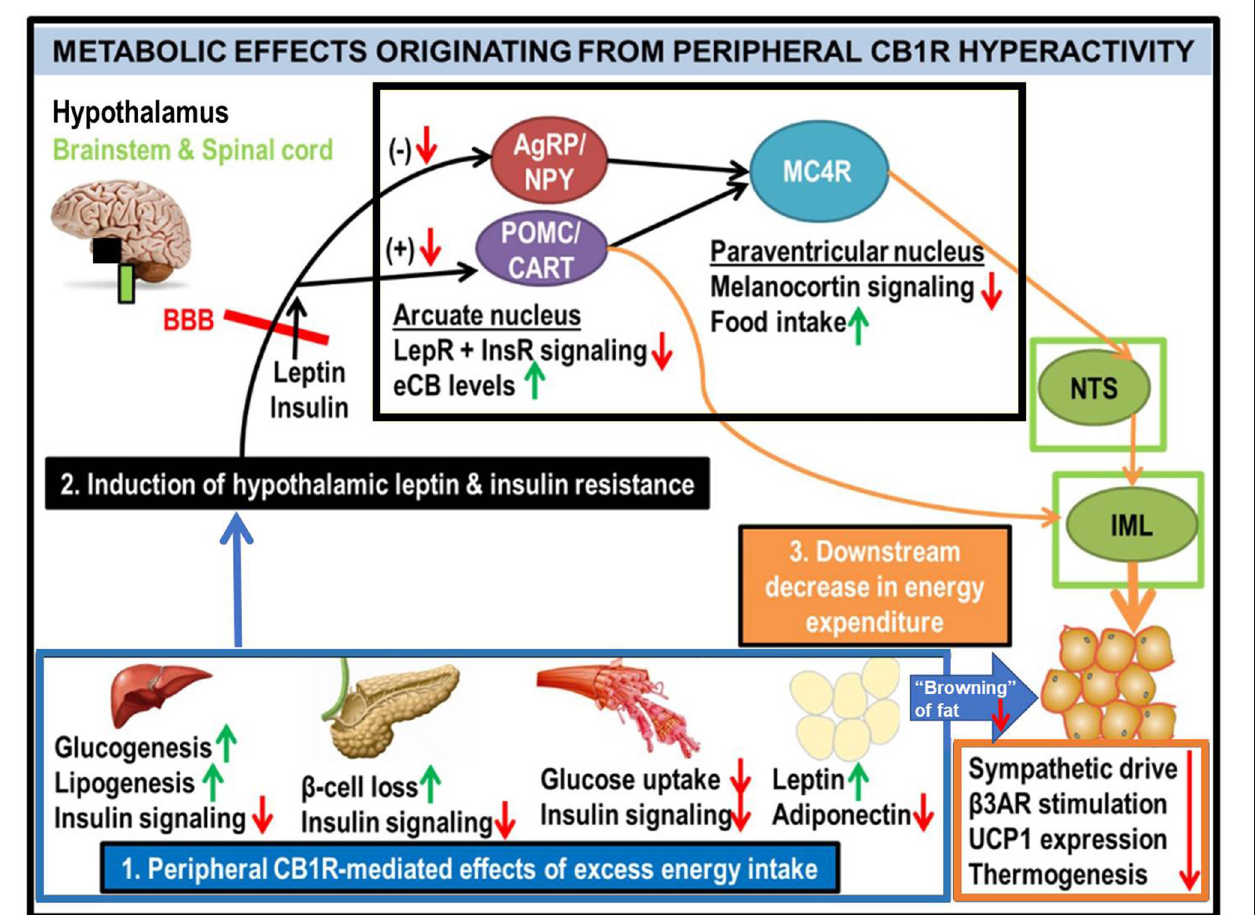
FIGURE 2 | Generalized schematic of how peripheral eCB/CB1R dysfunction leads to the metabolic consequences associated with obesity and T2D. All green or red arrows indicate the observed effects of increased peripheral CB1R signaling: green corresponds to a phenotype stimulated by peripheral CB1Rs, whereas red means that the effect is inhibited. Excessive intake of energy (especially in the form of palatable high-calorie foods spawned by recent agricultural and industrial advances) fuels dysfunctional overactivity of peripheral organ eCB/CB1R signaling cascades (1) . This phenomenon is consistently observed in a wide range of vertebrate model species, from zebrafish to rodents, and is recapitulated in clinical studies of human subjects. The sum of deleterious metabolic consequences induced by CB1R hyperactivity within individual organs manifests as systemic resistance to the actions of both leptin and insulin (2) , which, respectively, are typical features of obesity and T2D. Although circulating concentrations of these hormones are often increased in patients with metabolic disorders, the resistance in both peripheral organs and the central nervous system impairs the downstream signaling cascades normally produced by these hormones’ receptors (LepR and InsR). Upon crossing the blood-brain barrier (BBB), the synergistic actions of intact leptin and insulin signaling promote activation of the pro-opiomelanocortin/cocaine- and amphetamine-related transcript (POMC/CART) neurons within the hypothamalic arcuate nucleus (49). This population of neurons exists in a “tug-of-war” with the agouti-related peptide/neuropeptide Y (AgRP/NPY) neurons, as activation of one population inhibits the other. When leptin and/or insulin signaling is impaired, the activation of POMC/CART neurons is also suppressed, leading to a reduction in downstream melanocortin-4 receptor (MC4R) as well as elevation of intra-hypothalamic eCBs. Collectively, these alterations would lead to increased food intake, as MC4R activation within the paraventricular hypothalamus (PVH) promotes satiety upon arcuate LepR activation. In tandem, the reduced MC4R signaling output would hinder its transmissions to the sympathetic nervous system. Among the key affected regions are the brainstem’s nucleus tract solitarius (NTS), involved in the promotion of satiety (50), as well as the spinal cord’s intermediolateral column (IML), involved in energy expenditure via brown adipose tissue (BAT) thermogenesis (51–53). A convergent projection from the POMC neurons to the IML also regulates BAT activity. Together, this evidence supports the conclusion that insulin and leptin resistance resulting from peripheral CB1R dysfunction, can interfere with central pathways of energy balance (3)